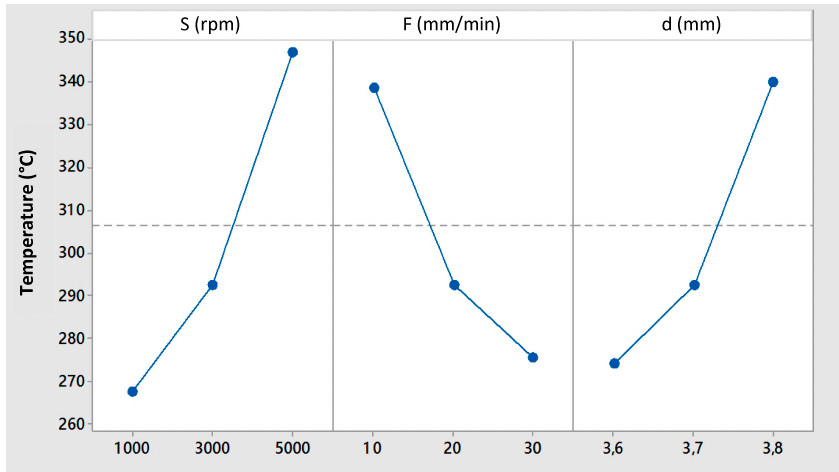
Figure 2. Main effects plot for temperature (T3).